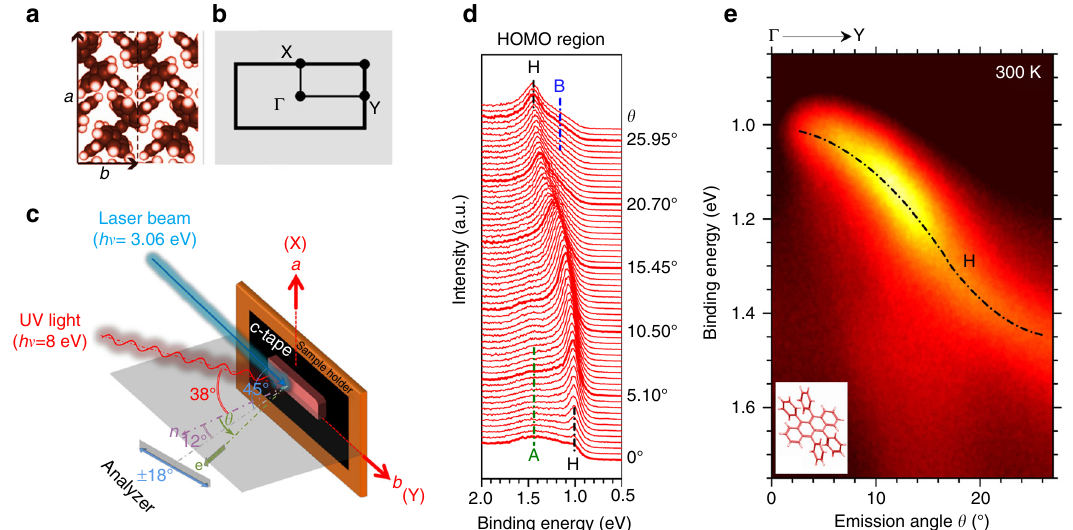
Fig. 1 Crystal structure with ARUPS experimental geometry and data of rubrene single crystal. Schematic of the molecular orientation in the crystalline a - b plane of rubrene single crystal ( a = 14.4 Å, b = 7.2 Å) in real a and reciprocal space b . c Schematic drawing of the experimental geometry. d θ dependence of the ARUPS spectra of rubrene at 300 K along the Γ Y direction. The peak positions of the HOMO (H) and of non-dispersive features a and b are indicated by dash dotted vertical lines (see text for further details). e ARUPS spectra intensity as a function of the emission angle θ along the Γ Y direction. The HOMO (H) dispersions is indicated by dash dotted black curve as guides for the eye. A sketch of the rubrene molecule is reported in the inset for